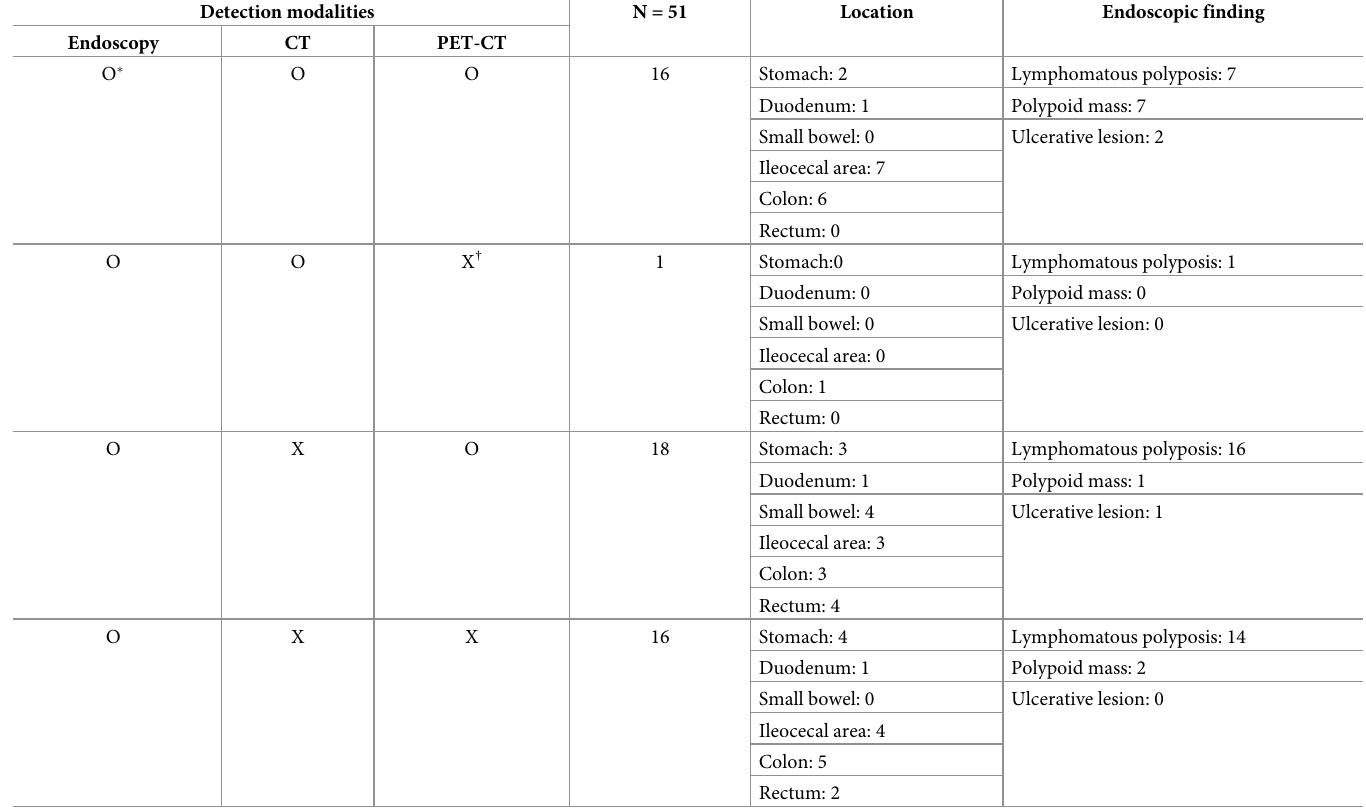
Table 2. Detection modalities and characteristics of 51 gastrointestinal lesions in 28 MCL patients with gastrointestinal tract involvement. Detection